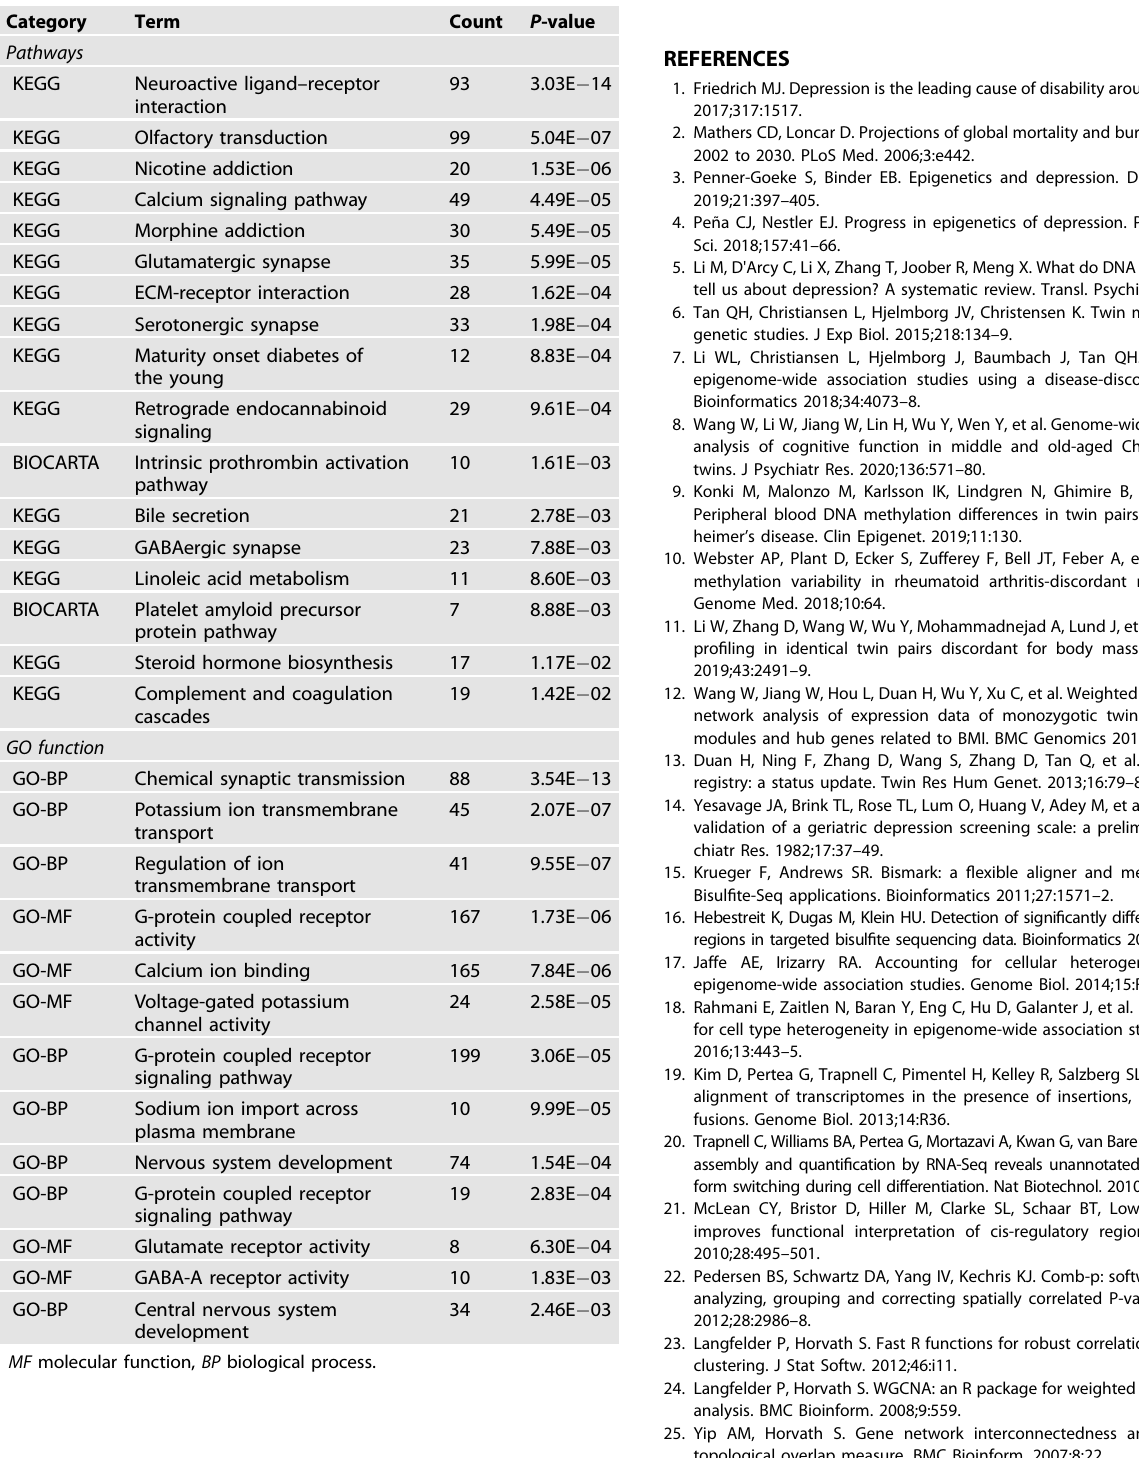
Table 5. The results of GO function and KEGG pathway enrichment analysis for genes clustered in pink module by DAVID